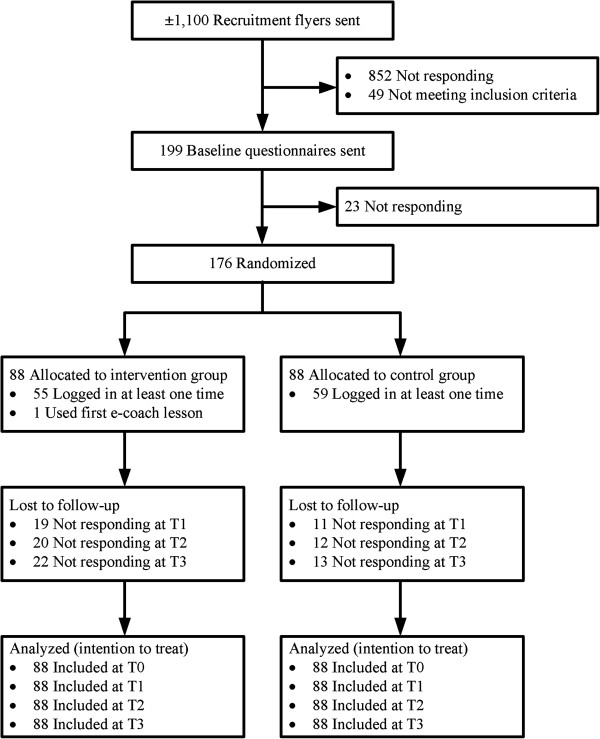
Participant flow chart.